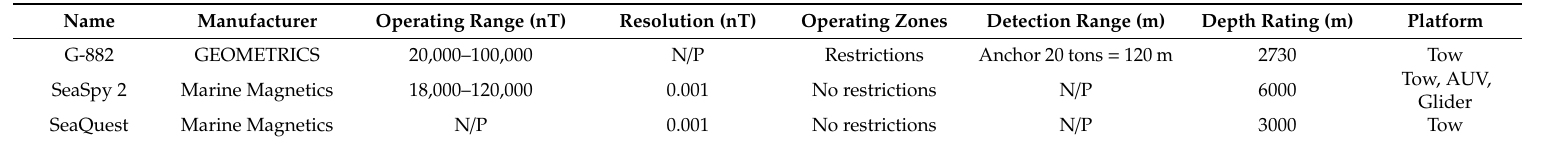
Table 19. Magnetometers and